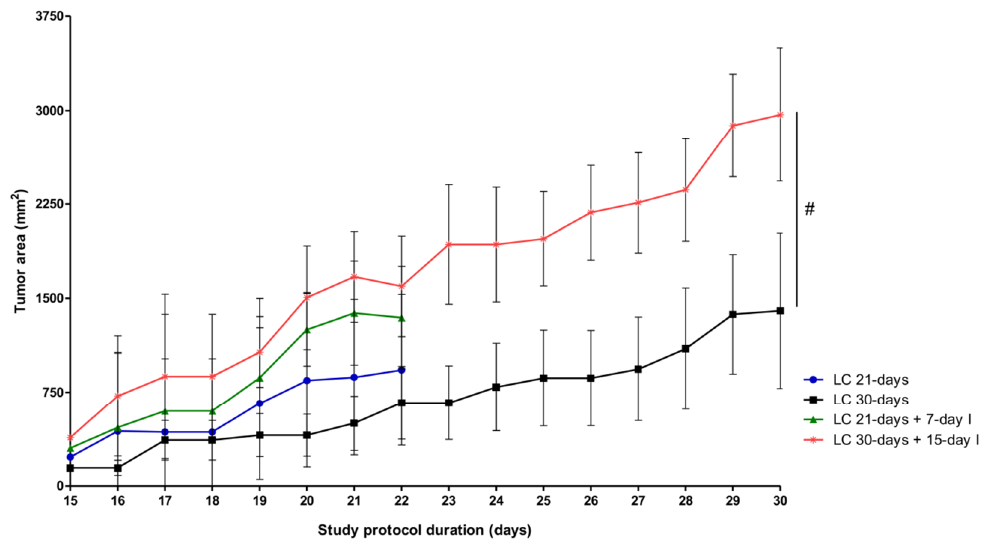
Figure 1. Mean values and standard deviation of subcutaneous tumor area (mm 2 ) of the di ff erent groups of LC-cachexia mice and animals with both conditions (LC-cachexia and unloading) during the study protocol. Comparisons were made among the di ff erent study groups at two time-points: last experimental day (day 21 or day 30) and at the initial time-point (day 15). Definition of abbreviations: mm, millimeter; I, immobilization; LC, lung cancer. Statistical significance is represented as follows: # p < 0.05 between any group of LC-cachexia mice and their respective group of mice bearing the two conditions (LC-cachexia and unloading) at the end of the study period. No significant di ff erences in tumor area were detected among the experimental